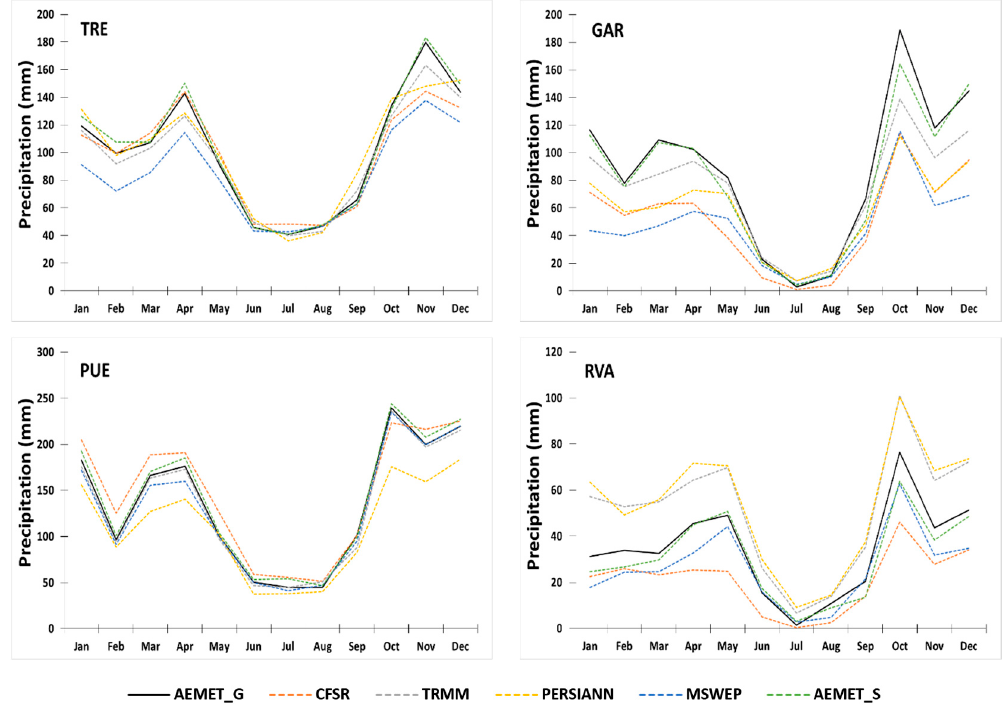
Figure 4. Long-term monthly areal precipitation of ground observations and gridded precipitation products in the 1998–2009 period. Table 4. Statistical indices used to quantify the accuracy of precipitation estimates against precipitation from AEMET_G (best results in bold).